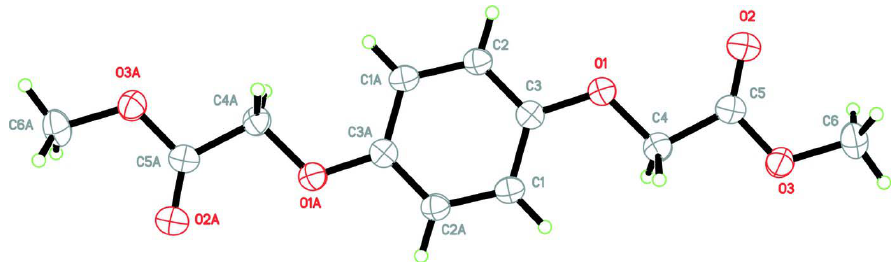
Figure 1 A view of the molecular structure of (I) showing the atom-numbering scheme. Ellipsoids are drawn at the 30% probability level. H atoms are represented as small spheres of arbitrary radii. [symmetry code: (A) 1/2-x, 1/2+y,